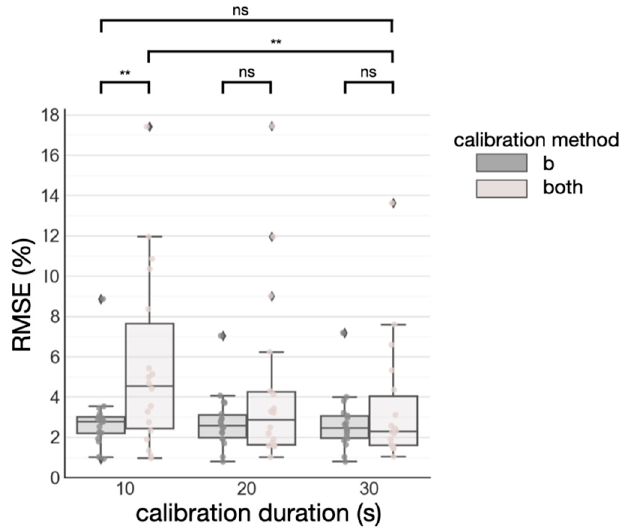
Figure 7. Calibration using b and using both b and m . ns denotes not significant ( p > 0.05), and a double asterisk denotes significant differences ( p < 0.01) as determined by paired sample